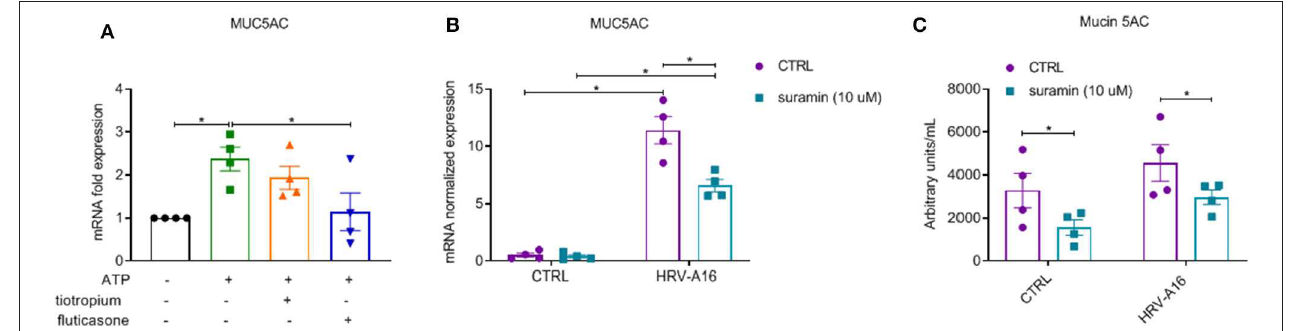
FIGURE 8 | Inhibition of fluticasone on ATP-induced mucin production and involvement of extracellular ATP in HRV-induced mucin production and release in ALI-PBEC. (A) ATP (100 µ M) treated cells in the presence of tiotropium or fluticasone. Cells were incubated for 24h. The gene expression of MUC5AC was measured using qPCR. (B) ALI-PBEC were infected by HRV-A16 (MOI 5) after pre-treatment with suramin (10 µ M). Cells were incubated for 48h after infection. The gene expression of MUC5AC was measured by qPCR. (C) Levels of Mucin 5AC were assessed by ELISA assay. Gene expression were normalized for RPL13A and ATP5B. Data are shown as normalized or fold expression. Data are mean values ± SEM. n = 4 independent donors. Analysis of differences was conducted with paired one-way or two-way ANOVA with a Tukey post-hoc test Significant differences are indicated by * P < 0.05 compared with control, HRV-A16 and ATP